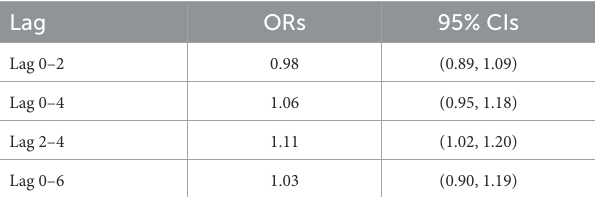
TABLE 3 ORs and 95% CIs of fracture associated with an IQR increase in ozone over multiple lag